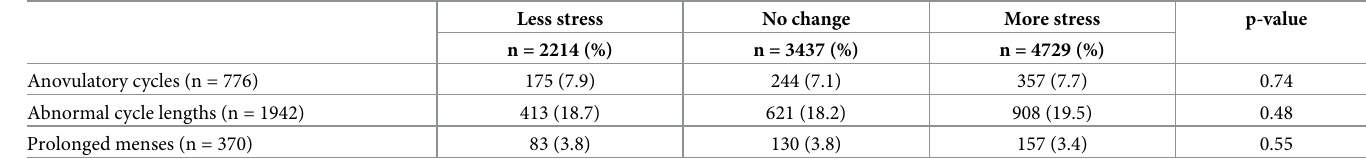
Table 3. Users reporting more cycle abnormalities during the COVID-19 pandemic, by change in perceived stress (N = 10,293 users).